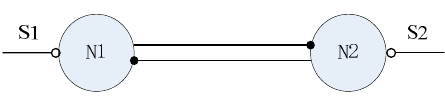
Figure 7. Network of two neurons that inhibit each other.